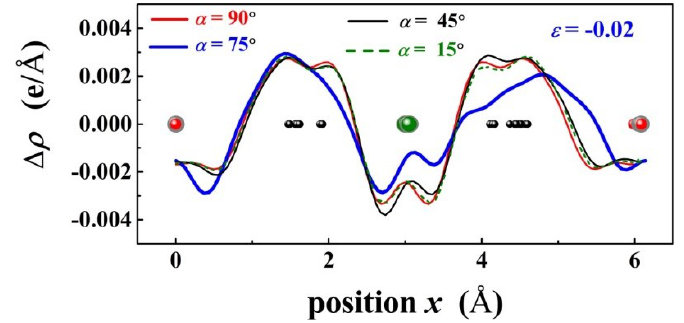
Figure 6. The plane averaged electron density difference ∆ ρ of PbPd 0.75 Co 0.25 O 2 projected along the x axis and under ε = − 0.02, with α = 15 ◦ , 45 ◦ , 75 ◦ , and 90 ◦ , respectively.